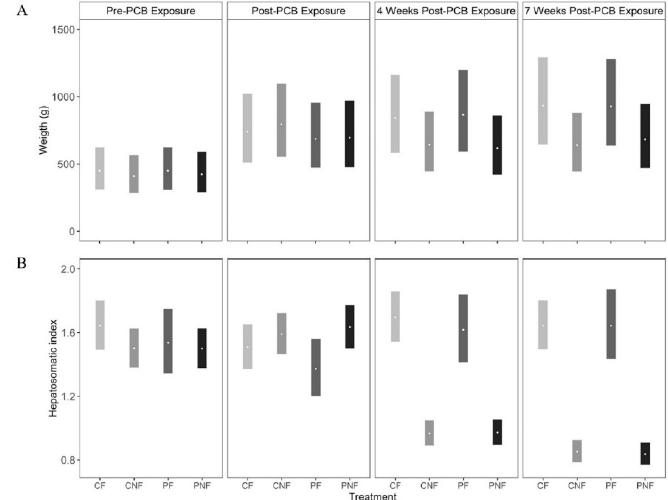
Figure 1. Posterior mean (open circles) and 90% credible intervals (bars) for ( A ) weight and ( B ) hepatosomatic index for channel catfish in each of four treatments (CF = control and fed, CNF = control not fed, PF = polychlorinated biphenyl (PCB) exposed and fed, PNF = PCB exposed and not fed). Weight and hepatosomatic index were measured before PCB exposure, after 11 weeks of PCB exposure, and four and seven weeks after PCB exposure, during which time fish in the CNF and PNF treatments were also deprived of